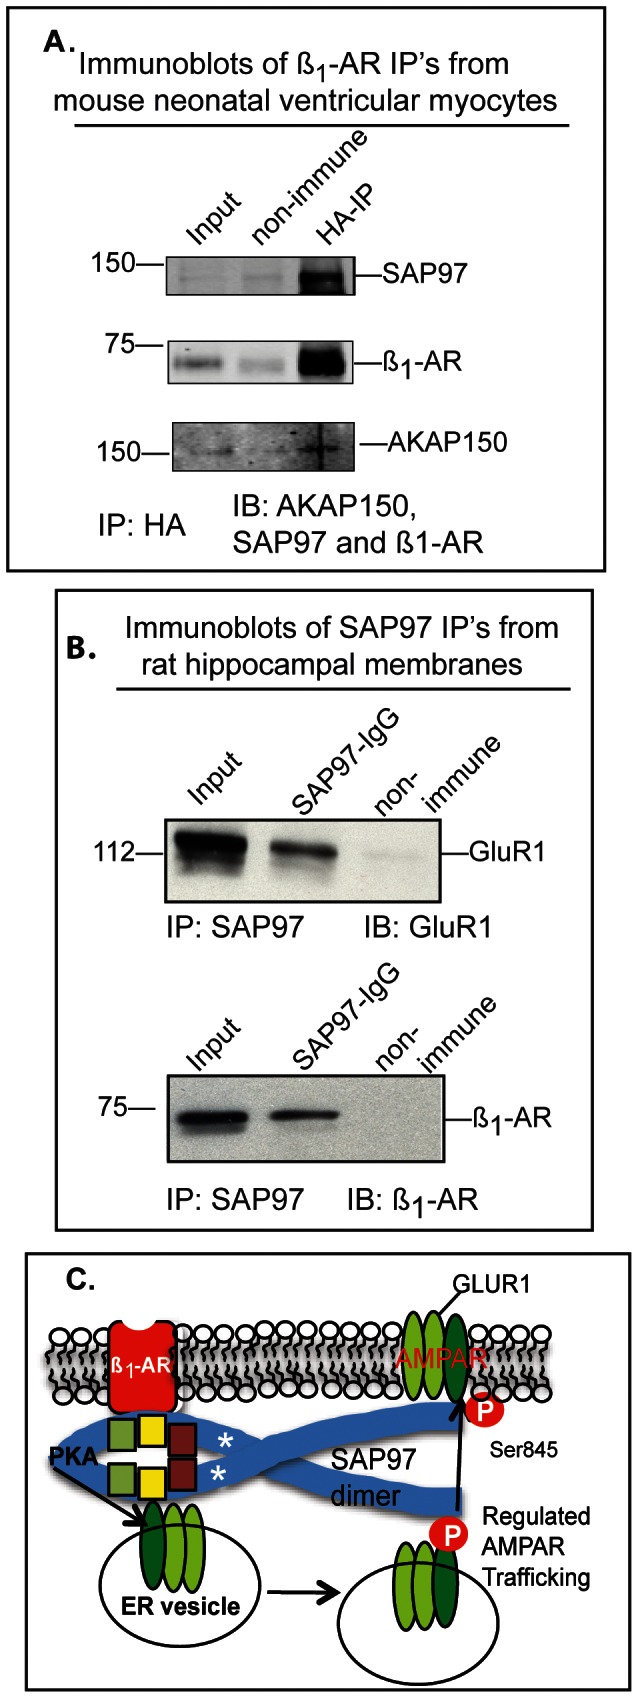
Characterization of molecular interactions between the ß1-AR and SAP97 and AKAP79/150 in cardiac and neuronal tissue.
A, mouse neonatal cardiac myocytes were infected with an adenovirus harboring HA-tagged mouse ß1-AR. Then input lysates were immunoprecipitated with anti-HA resin (IP). The resin was eluted and equal amounts of eluate were subjected to Western blotting (IB) and probed with antibodies to AKAP150, SAP97 and ß1-AR. B, lysates of rat hippocampal membranes were incubated with 1∶200 dilution of anti-SAP97 IgG (Enzo Life sciences) or mouse IgG for 16 h at 4°C. Then 30 µl of protein G-agarose was added for 2 h, followed by 4 washes of the resin in complete RIPA buffer. The beads were suspended in 2X Laemmli sample buffer with 20 mM dithiothreitol for 45 min at 37°C. The cleared eluates were divided equally and subjected to SDS-PAGE on 8% (GluR1) or 10% (ß1-AR) gels followed by electroblotting to nitrocellulose membranes. These membranes were probed with anti-GluR1 (sc-28799) or ß1-AR (sc-568) antibodies from Santa Cruz Biotechnology. C, diagram representing the binding of SAP97 dimers to the ß1-AR in postsynaptic membranes and to the GluR1 subunit of AMPAR in a postsynaptic membrane specialization commonly categorized as the “perisynaptic membrane”. We hypothesize that activation of the ß1-AR signalosome ultimately activates PKA, which in turn phosphorylates the GluR1 subunit of AMPA receptors on Ser845 to initiate regulated trafficking of AMPA receptors from perisynaptic membranes to postsynaptic membranes [39]–[41].